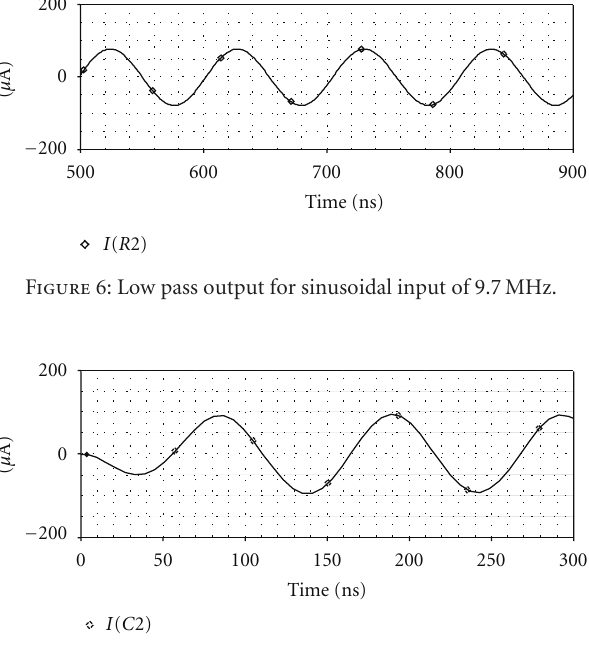
Figure 7: Band pass output for sinusoidal input of 9.7MHz.